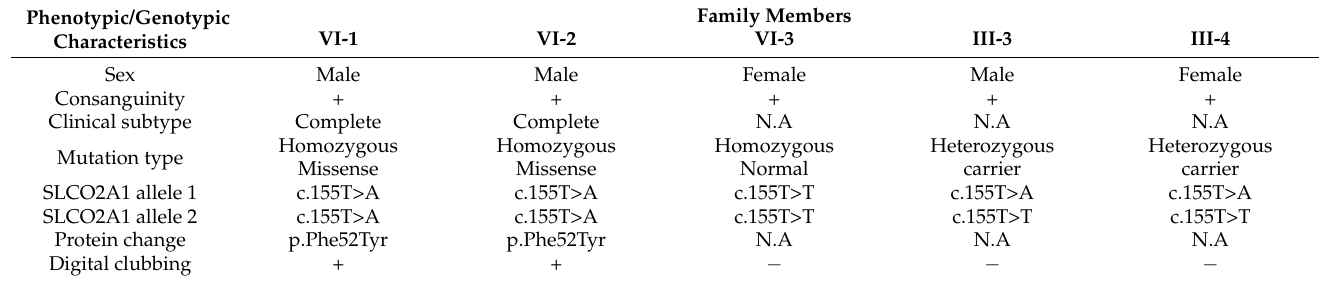
Table 1. Clinical/genetic features observed in the family under study carrying SLCO2A1